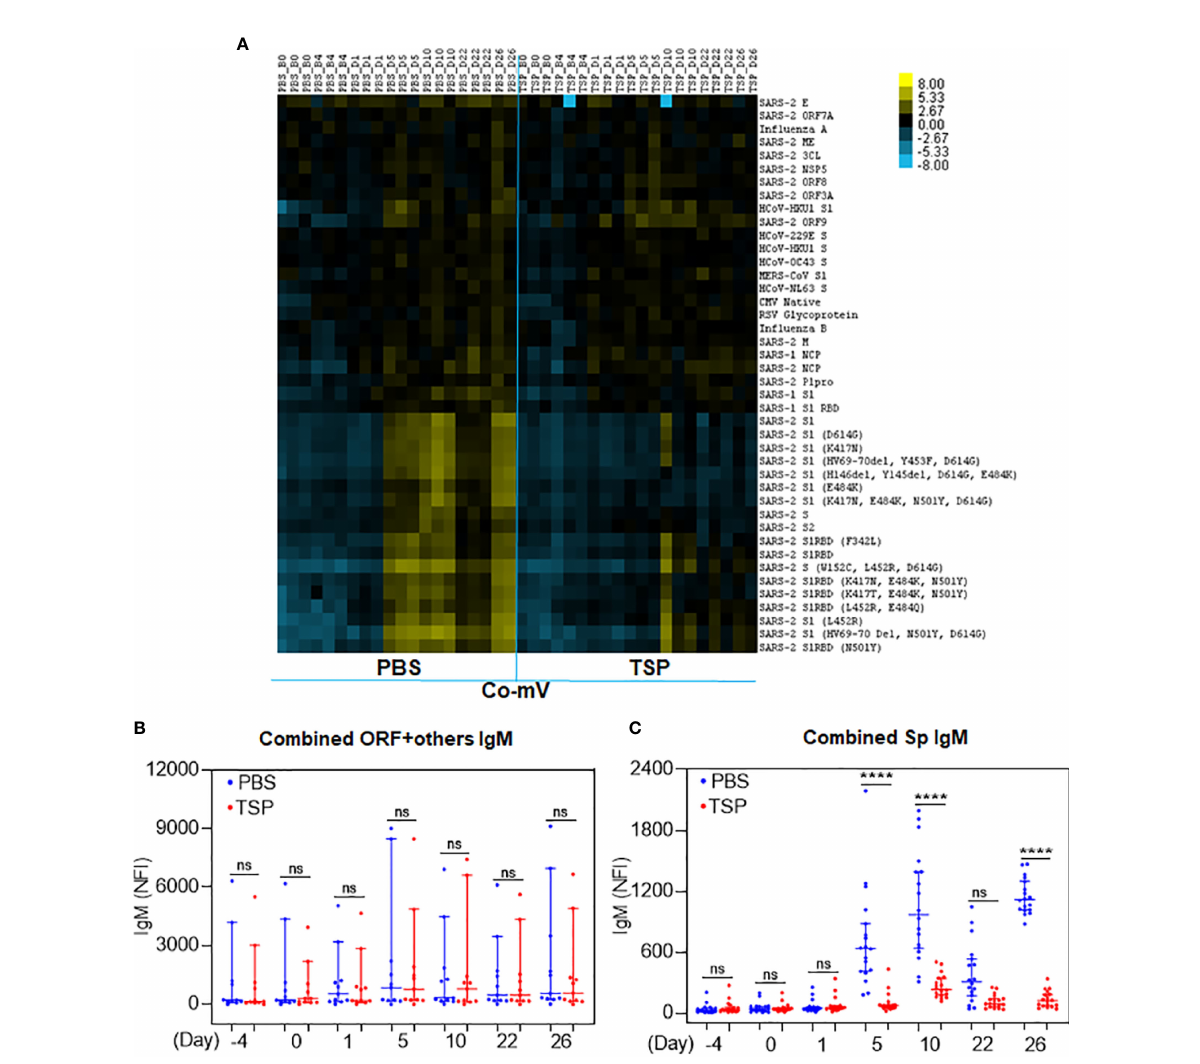
FIGURE 5 TSP drug combination attenuated the Co-mV- production of IgM antibodies against SARS-CoV-2 viral antigens in Balb/C mice in vivo . IgM antibody pro fi le to SARS-CoV-2 viral antigens in the PBS vehicle treated and TSP drug combination treated Balb/C mice that were immunized with P fi zer Co-mV, as indicated in materials and methods. (A) The heatmap shows IgM reactivity expressed in terms of row z-score for a respective antigen across different mice samples. Each antigen was organized into rows with serum specimens organized into columns classi fi ed as B0 (Baseline 0 th day, 6 samples), B4 (Baseline 4 th day – 6 samples), D1 (day 1 after PBS or TSP administration – 3 samples each), D5 (day 5 after PBS or TSP administration – 3 samples each), D10 (day 10 after PBS or TSP treatment – 3 samples each), D22 (day 22 post PBS